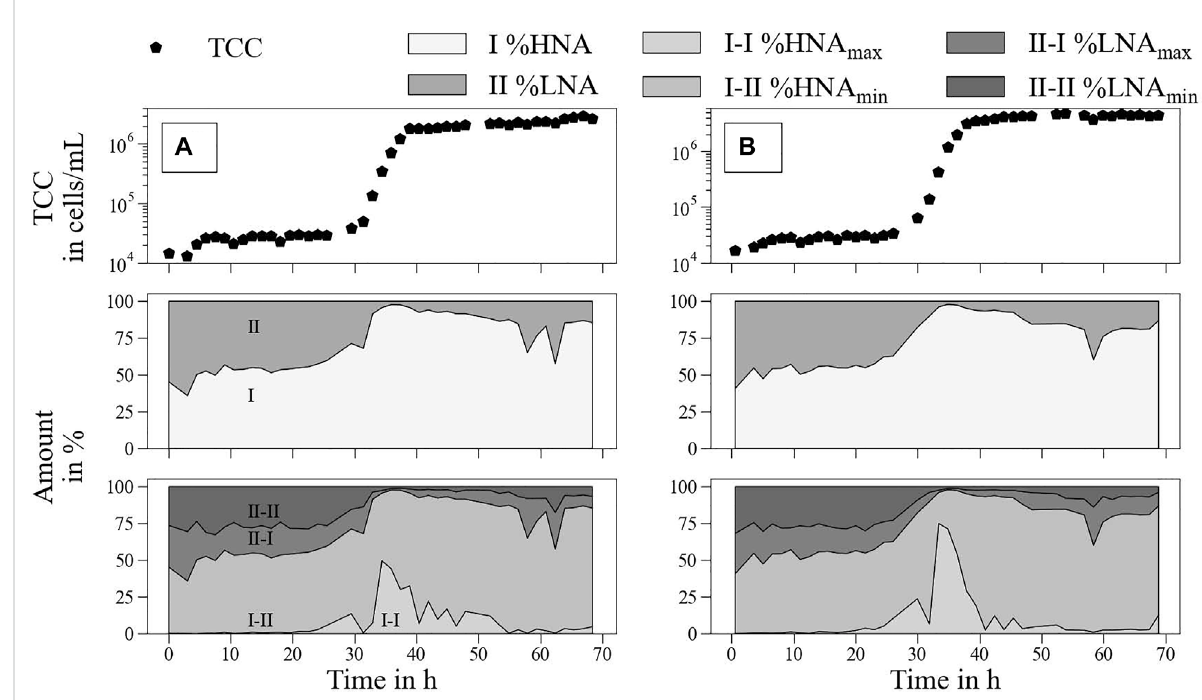
FIGURE 7 Real-timemonitoringofdetailedmicrobial fi ngerprintsoverapproximately70 h (A) — S4tapwater+vol%0.014LBmedium; (B) — S5tapwater+ vol% 0.029 LB